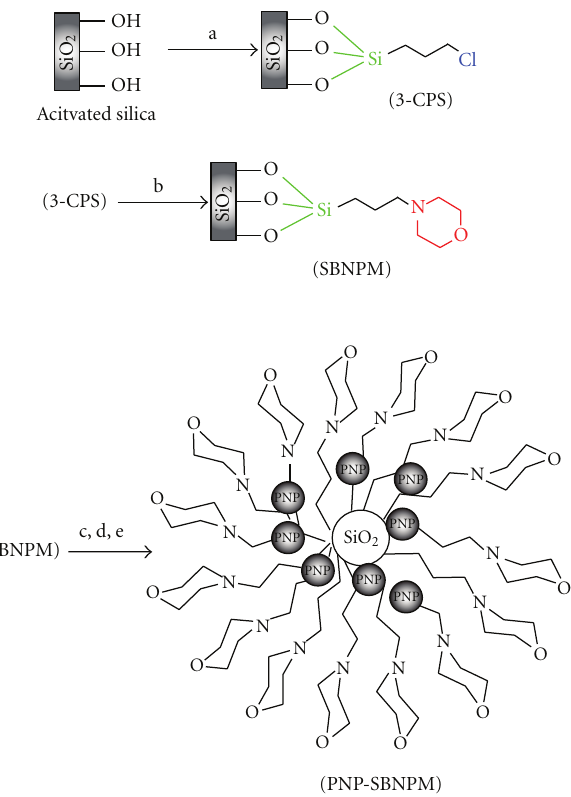
Figure 1: Preparation of PNP-SBNPM catalyst. (a) (3-chloropro- pyl) trimethoxysilane, toluene, reflux, 18h. (b) Morpholine, CHCl 3 , Et 3 N, 8h. (c) Pd(OAC) 2 , ethanol, r.t, 12h. (d) Washing with ethanol. (e) Washing with